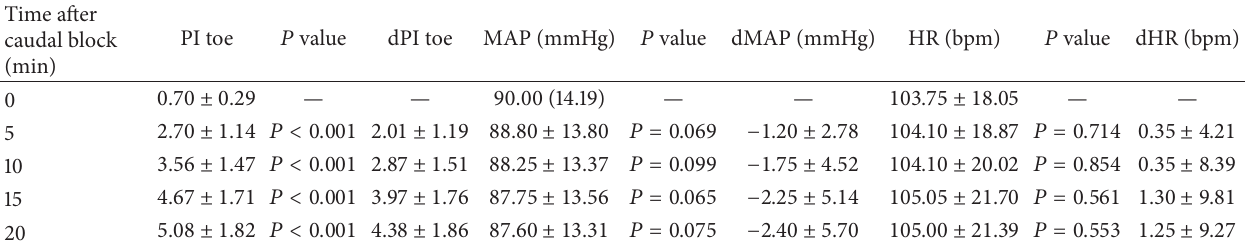
Table 2: Bedside indices for the onset of caudal block under ketamine basal anesthesia: changes over time following caudal lidocaine administration.